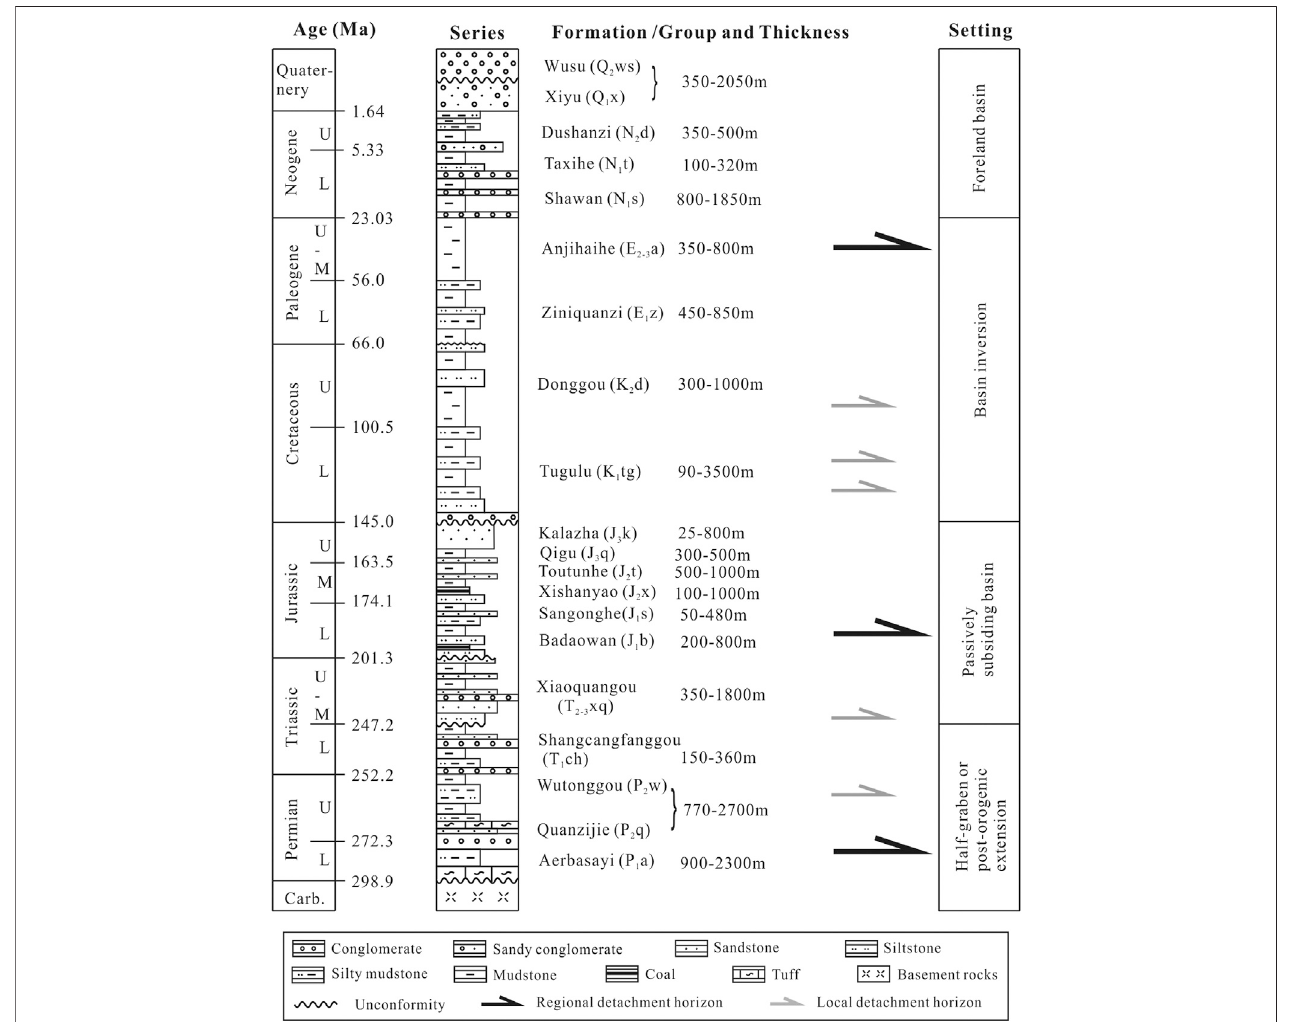
FIGURE 2 | Stratigraphic column showing the main stratigraphic units in the study region (Bureau of Geological and Mineral Resources of the Xinjiang Uygur Autonomous Region, 1985), and the tectonic setting that the region experienced (Yang et al., 2013).